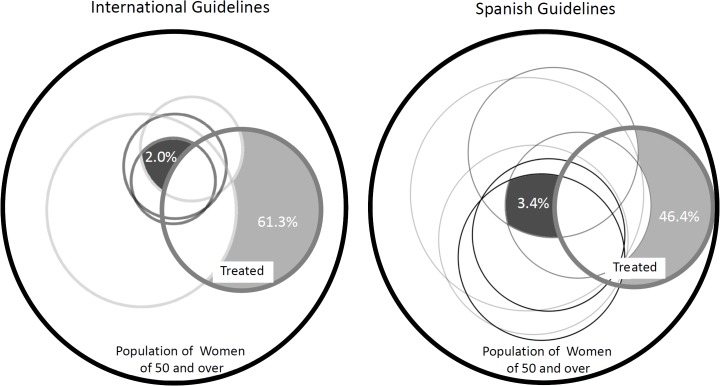
Overuse and underuse of osteoporotic treatment in women of 50 and over.The black external circle indicates the total population of women aged 50 and over and the thick gray line circle the proportion of women treated. Each one of other circles represents women who should be treated according to different international (left) or Spanish (right) guidelines. The light gray area denotes the percentage of women treated who do not require treatment (overuse) according to either all international or Spanish guidelines. The dark gray area denotes the percentage of untreated women requiring treatment according to either all international or Spanish guidelines.